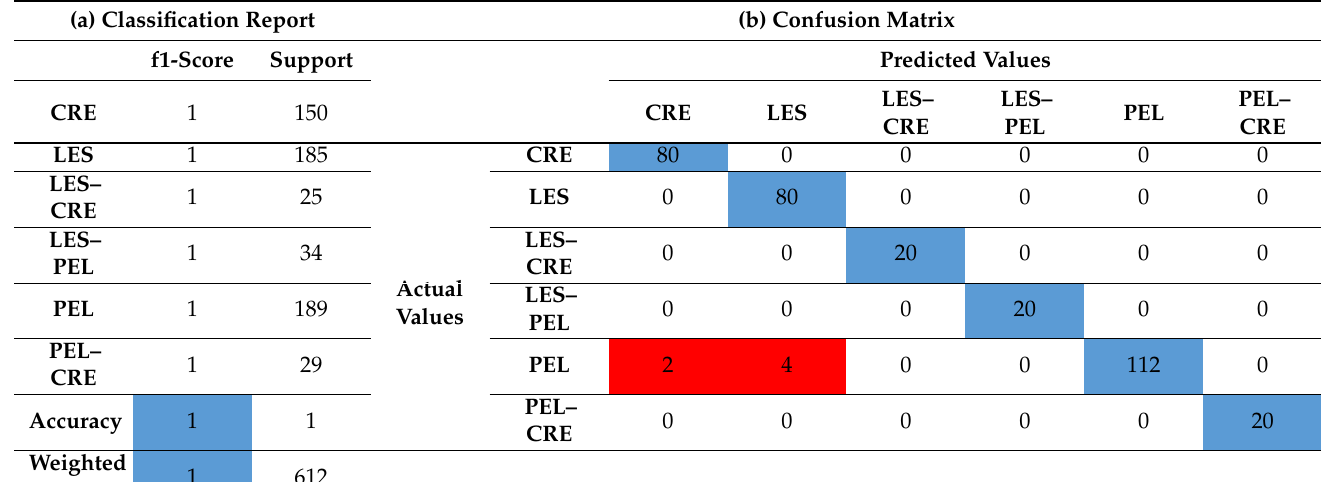
Table 5. Summary of the algorithmic accuracies.